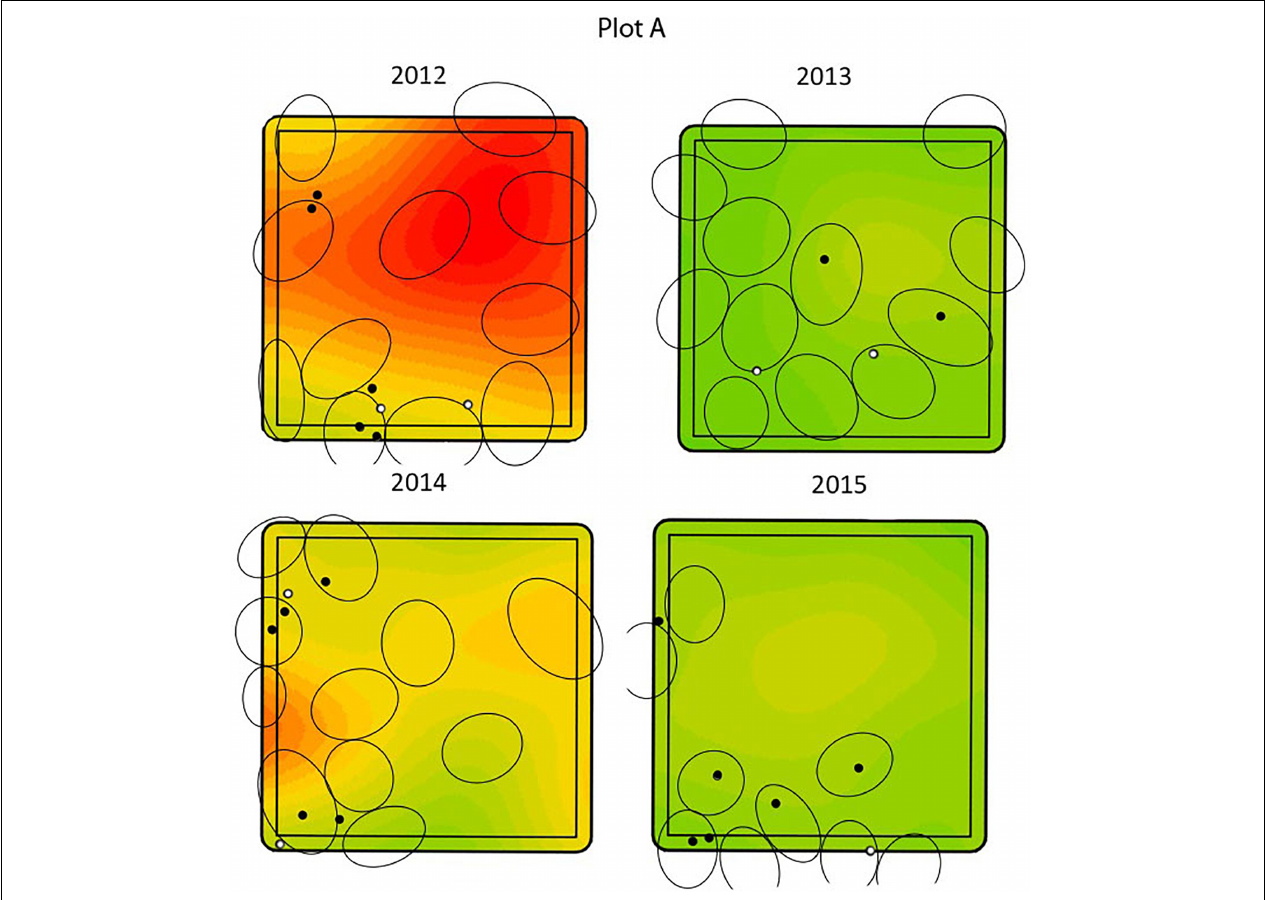
FIGURE 3 | Distribution of Ovenbird territories, kernel densities of Eastern Chipmunk activity, and songbird nests found in study plot A. See Figure 1 for meaning of color coding. Ovenbird territory locations are shown by ellipses. Black dots represent Ovenbird nests and white dots, Hermit Thrush